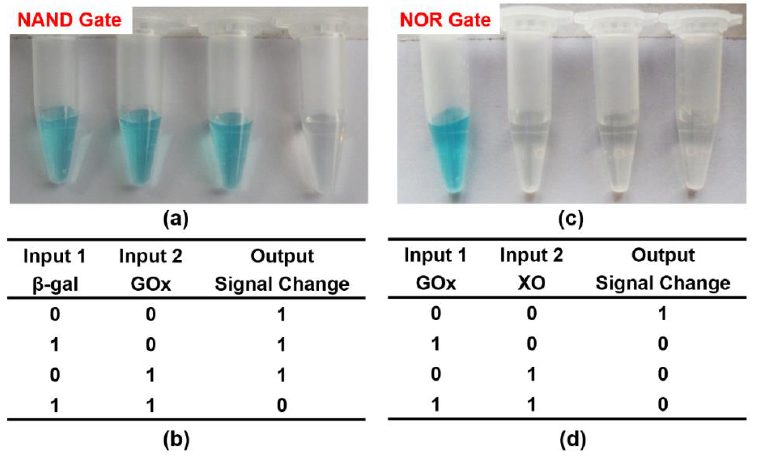
Figure 6. Output results and truth table of different logic gates: ( a , b ) NAND, ( c , d ) NOR. ([TMB] = 120 µ M, [CeO 2 NPs] = 4 µ g/mL, [lactose] = 25 mM, [glucose] = 5mM, [ β -gal] = 10 units/ mL, [GOx] = 1 unit/mL, [xanthine] = 100 µ M, [XO] = 0.04 unit/mL, [citrate buffer] = 40 mM, pH 6.0).